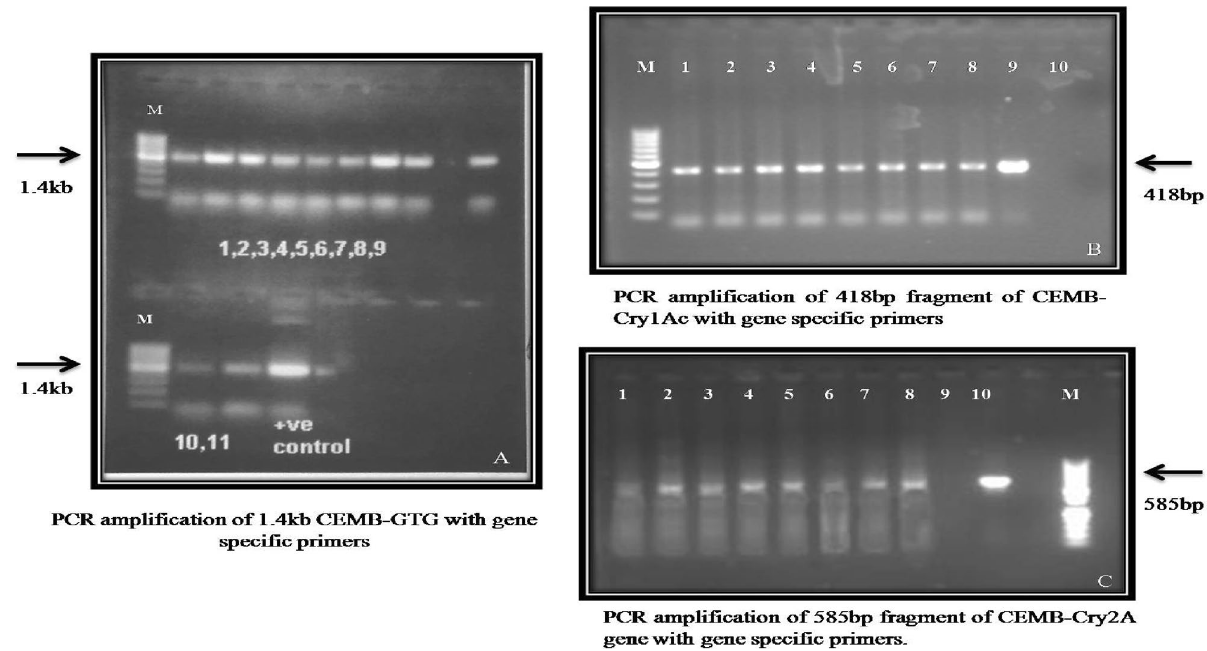
Figure 15. PCR amplified transgenic plants of CPF-246 for CEMB- Cry 1Ac, CEMB- Cry 2A and CEMB- GTGene. ( A ) Lane M: 1 kb DNA Ladder, Lane 1–11: Putative transgenic sugarcane plants with CEMB-GTGene (1.4 kb) Lane + ve: Positive control Lane 13: Non-transgenic plant (control plant). ( B ) Lane M: 1 kb DNA Ladder Lane 1–8: Putative transgenic sugarcane plants with CEMB- Cry 1Ac (418 bp) Lane 9: Positive control Lane 10: Non-transgenic plant (control plant). ( C ) Lane M: 1 kb DNA Ladder Lane 1–11: 1–8 Putative transgenic sugarcane plants with CEMB- Cry 2A (585 bp) Lane 9: Non-transgenic plant (control plant), Lane 10: Positive control.